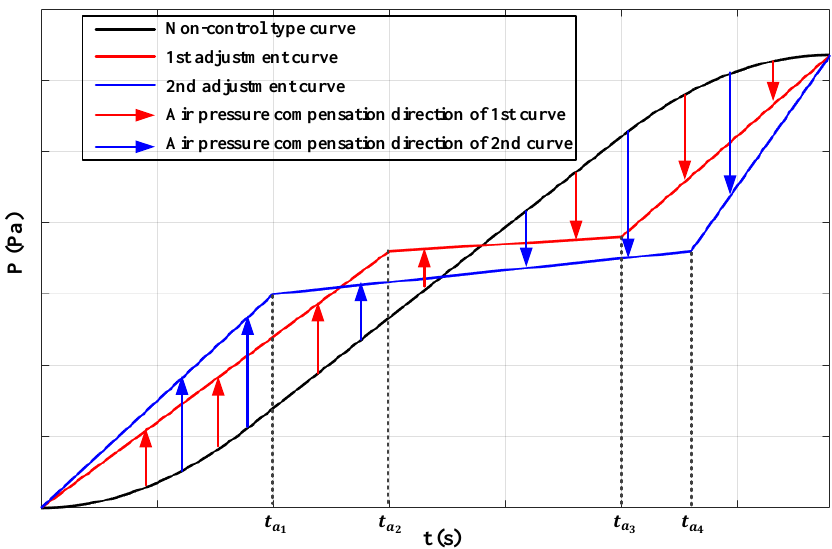
Figure 6. Comparison of different adjustment curves.